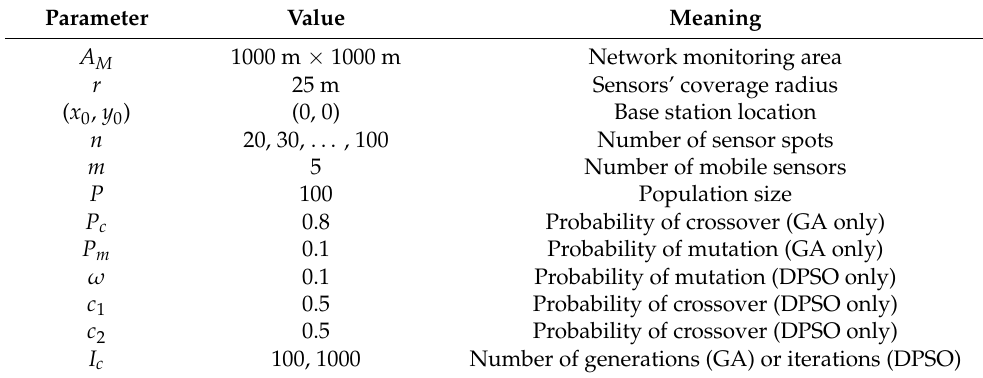
Table 1. Parameter settings in the